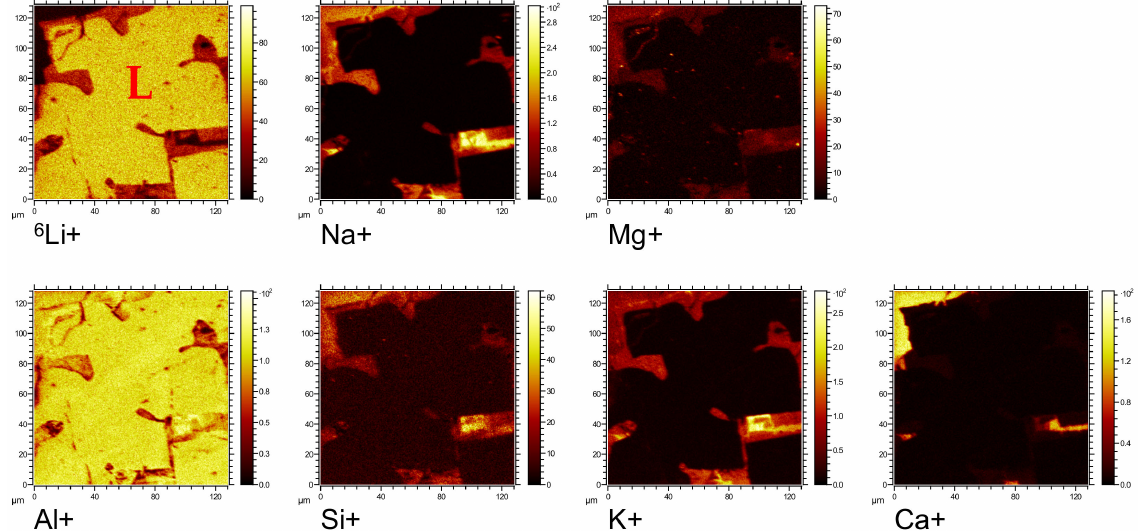
Figure 3. Details of the lateral intensity distributions of selected positive isotope-resolved secondary ion signals of a skeleton crystallizate LiAl-phase (L) in a Ca-alumosilicate